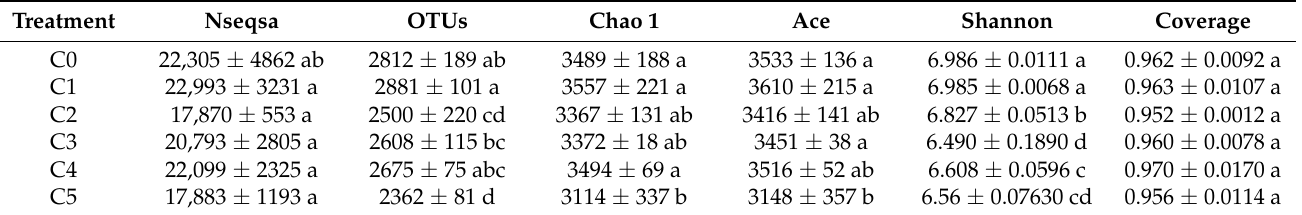
Table 2. Bacterial community alpha diversity based on the 16S rRNA gene library (similarity threshold of 97%) sequenced by an Illumina MiSeq